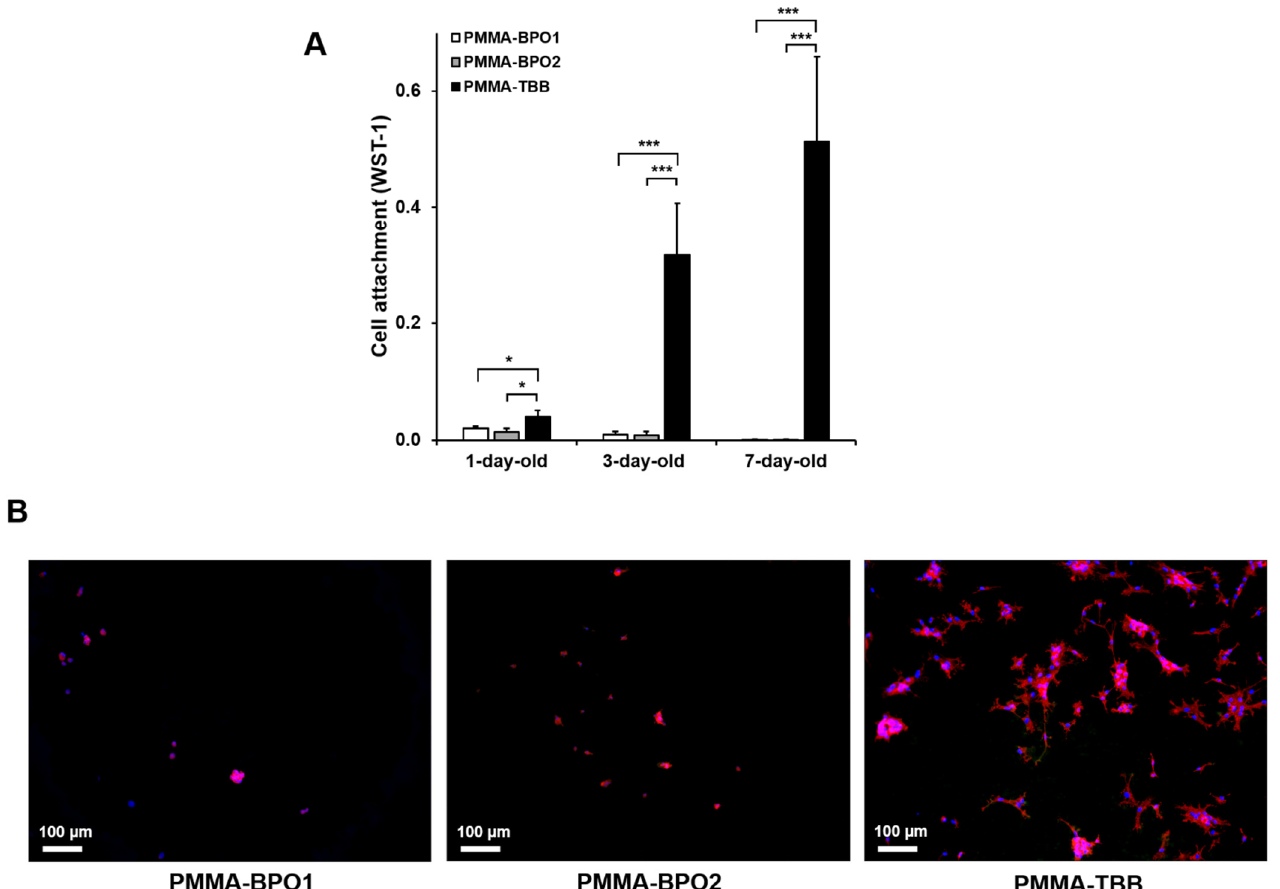
Figure 1. The initial cellular attachment of osteoblasts on the three different types of bone cements (two PMMA-BPO cements and one PMMA-TBB cement) prepared for different amounts of time. Osteoblasts were seeded onto one-day, three-day, and seven-day post-polymerization bone cement specimens. ( A ) The number of cells attached to bone cements on day two of culture evaluated by the water-soluble tetrazolium salt-1 (WST-1) assay. Data are shown as mean ± SD ( n = 3). Statistical differences between the three groups are shown (two-way ANOVA followed by Bonferroni test, * p < 0.05, *** p < 0.001). ( B ) Fluorescently stained osteoblasts on day two of culture on seven-day-old bone cement specimens. Representative fluorescence microscopy images of cells visualized with rhodamine phalloidin for actin filaments (red) and 4 ′ ,6-diamidino-2-phenylindole (DAPI) for nuclei (blue) are shown. Scale bar = 100 µm. PMMA-BPO, polymethyl methacrylate-benzoyl peroxide; PMMA-TBB, polymethyl methacrylate-tri-n-butylborane.